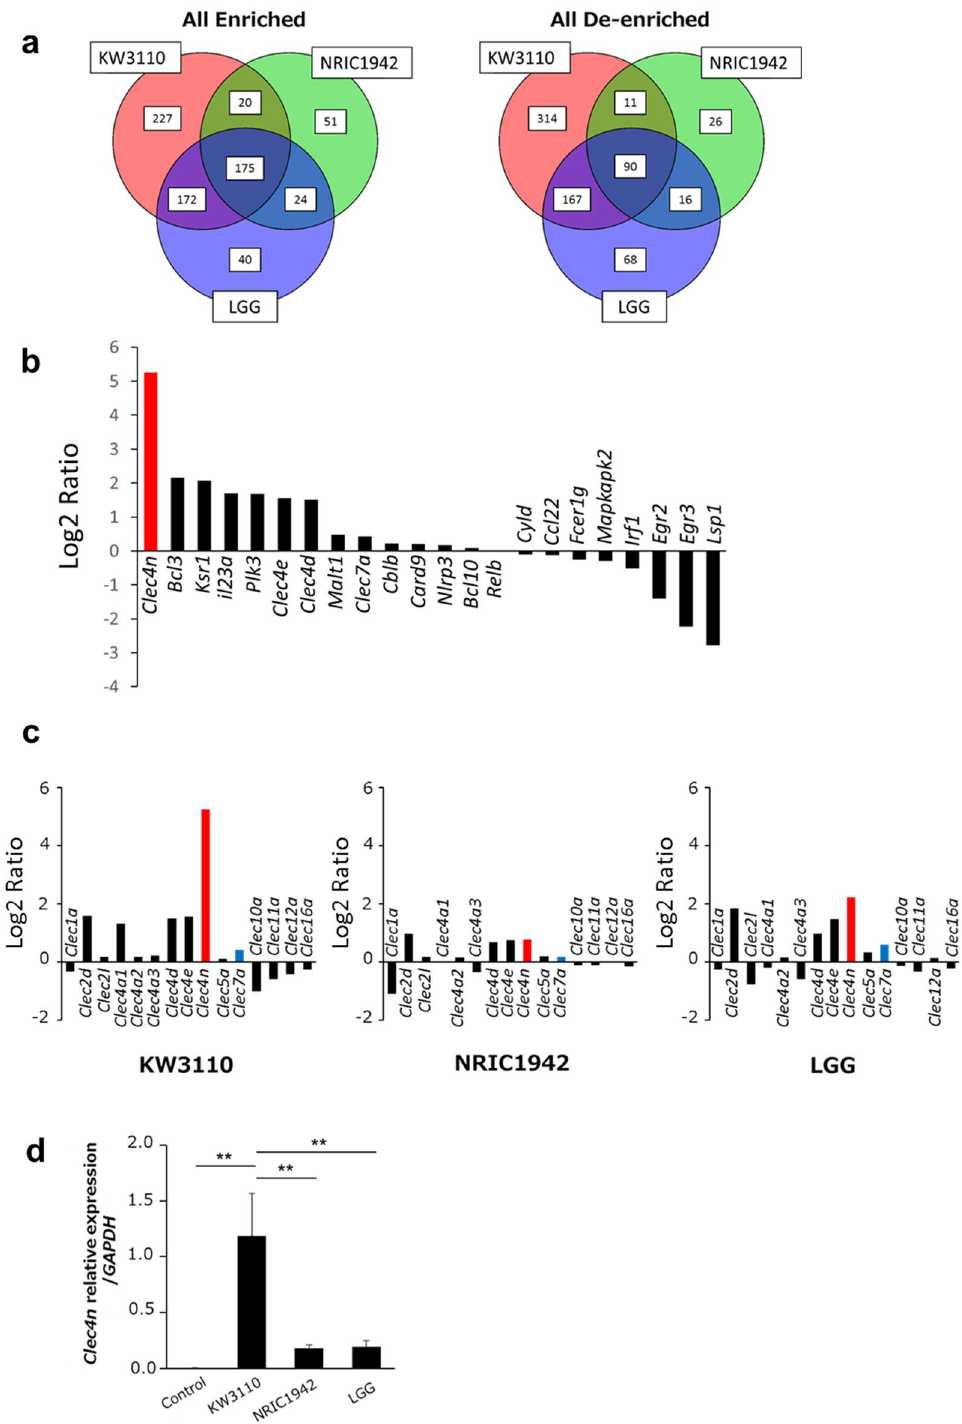
Figure 3. Dectin-2 involvement in KW3110 phagocytosis. ( a ) Venn diagram of up- (left) or down- (right) regulated genes in stimulated and non-stimulated RAW 264.7 cells by each Lactobacilli . ( b ) Variance of gene expression in the cluster of C-type lectin receptor genes after stimulation by KW3110. The cluster is defined by KEGG. The gene expressions were compared between KW3110 stimulated and non-stimulated RAW 264.7 cells. Clec4n gene expression is represented by a red bar. ( c ) Gene expression variance of C-type lectin domain genes when stimulated by each Lactobacilli . Gene expressions were compared between stimulated and non- stimulated RAW 264.7 cells. The gene expression of Clec4n and Clec7a are represented by red and blue bars. ( d ) Clec4n expression in RAW cells stimulated by Lactobacilli (relative expression levels normalized to GAPDH). Significant differences were compared to the control group, ** p < 0.01. Data are the means ± SD. Data are representative of at least three independent